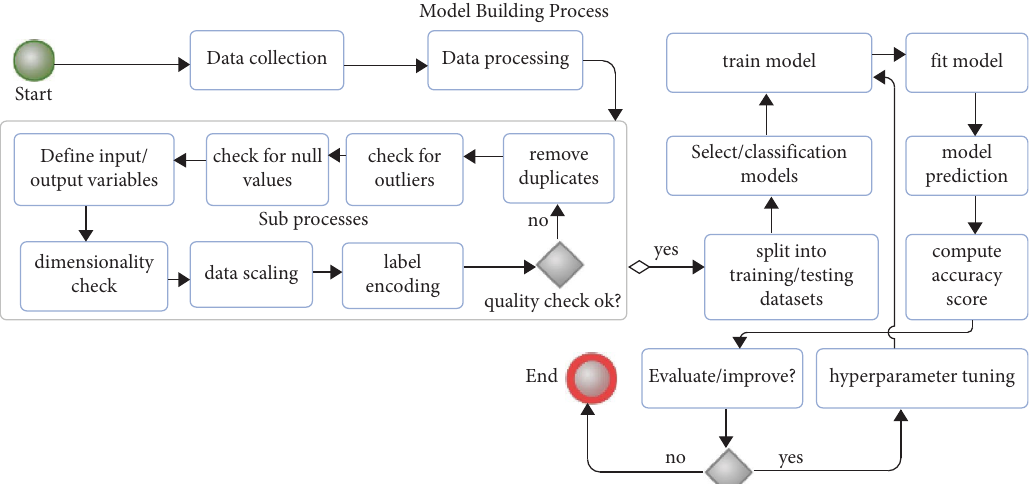
Figure 7: A fowchart diagram of a model building process. Te rectangles show processes, the arrows indicate task routes, and the rhombus show decision points and circles depict the start or end of processes (circular green, start and circular red,